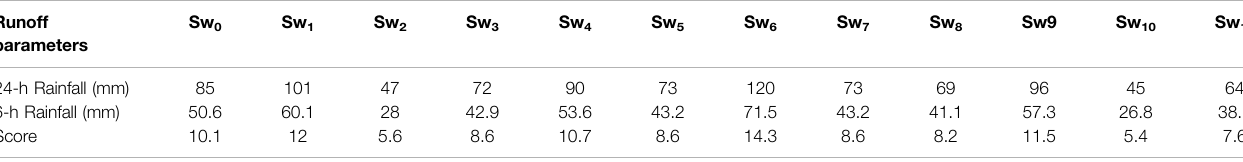
TABLE 5 | Runoff factor parameter. Runoff parameters